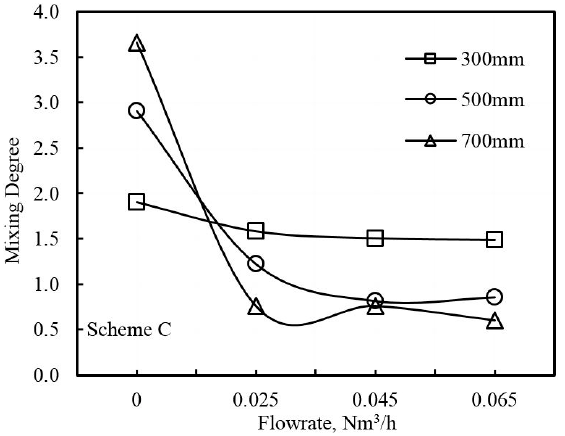
Figure 15. Mixing degree as a function of bottom blowing flowrate using Scheme C.